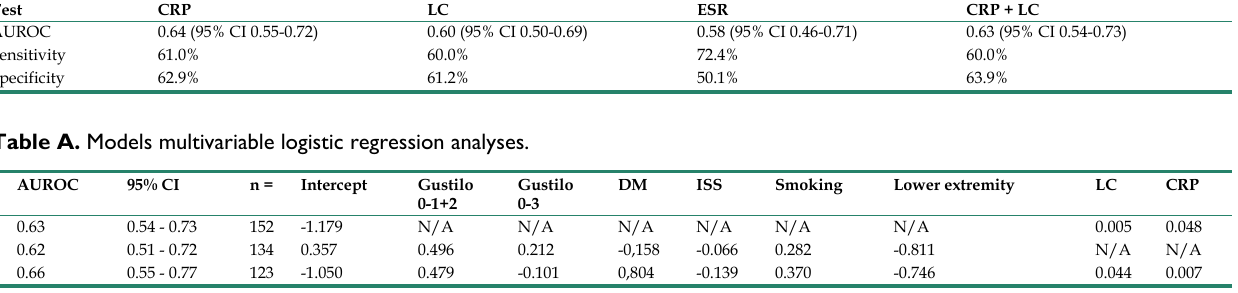
Table 5. Diagnostic accuracies for continuous variables CRP, LC, ESR and CRP + LC. Test